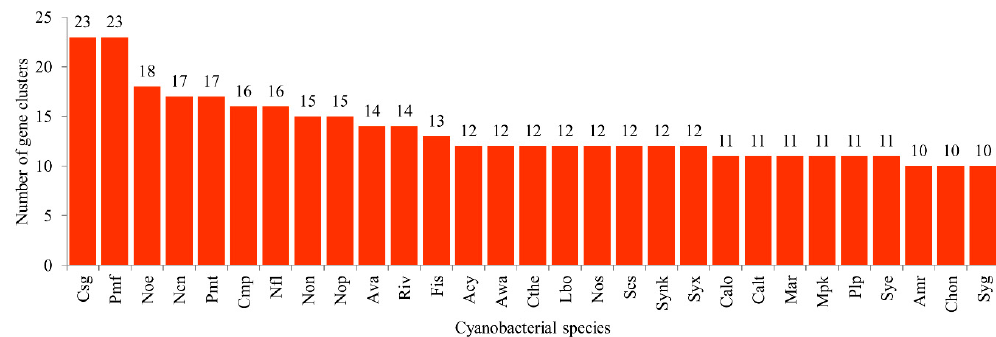
Figure 6. Comparative analysis of secondary metabolite biosynthetic gene clusters (BGCs) in cyanobacterial species. Species with a two-digit number of secondary metabolite BGCs are shown in the figure. The species names with respect to their codes can be found in Table S1. Detailed information on each of the species’ secondary metabolite BGCs is presented in Table